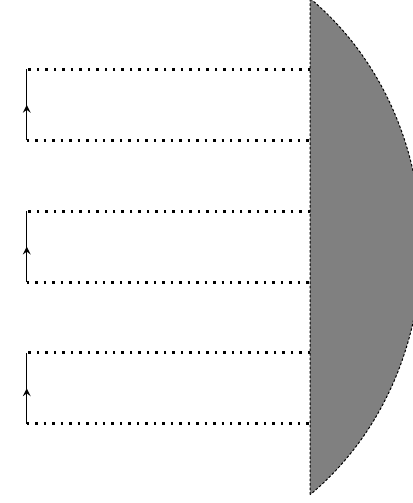
Figure 3 . The three contributions to the amplitude corresponding to the sum over bordisms with two interval boundaries.